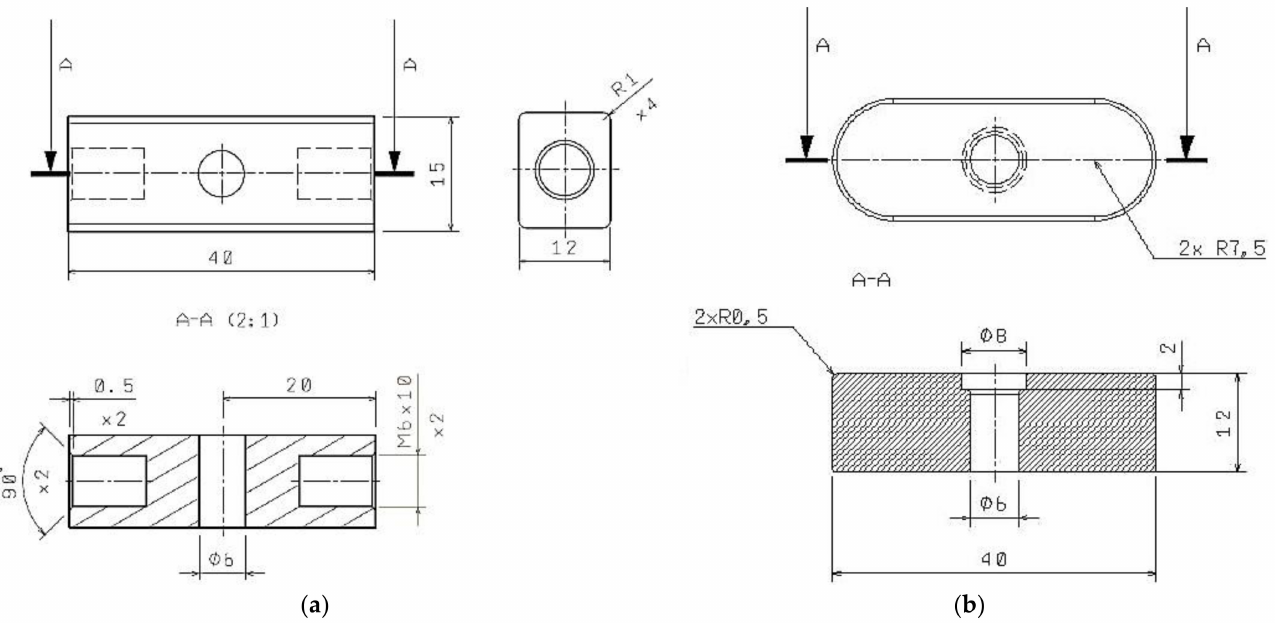
Figure 5. The exact geometry of the connecting rod stone ( a ) and auxiliary stone ( b ) used to build a real engine prototype to verify its functionality.